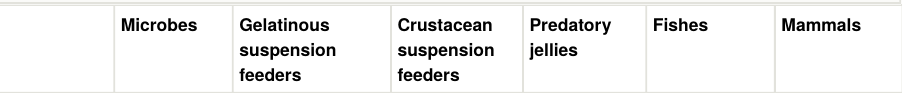
The direct e ff ects of sediment plumes on deep midwater taxa. The impacts of light and noise are not included